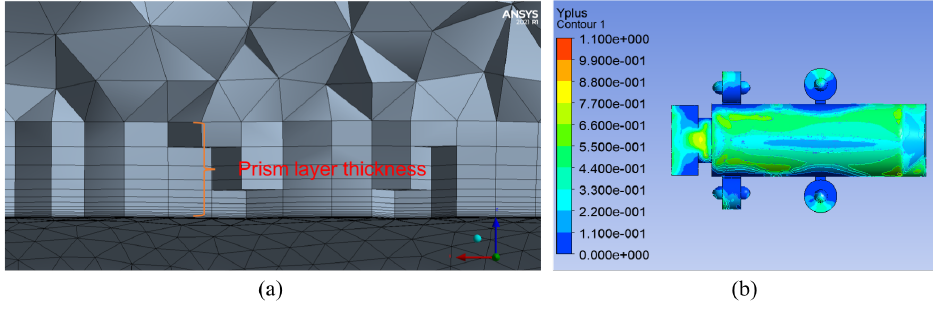
Figure 3. ( a ) Prism layers generated on the underwater vehicle model. ( b ) Visualization of y + value over the surface of the underwater vehicle model.